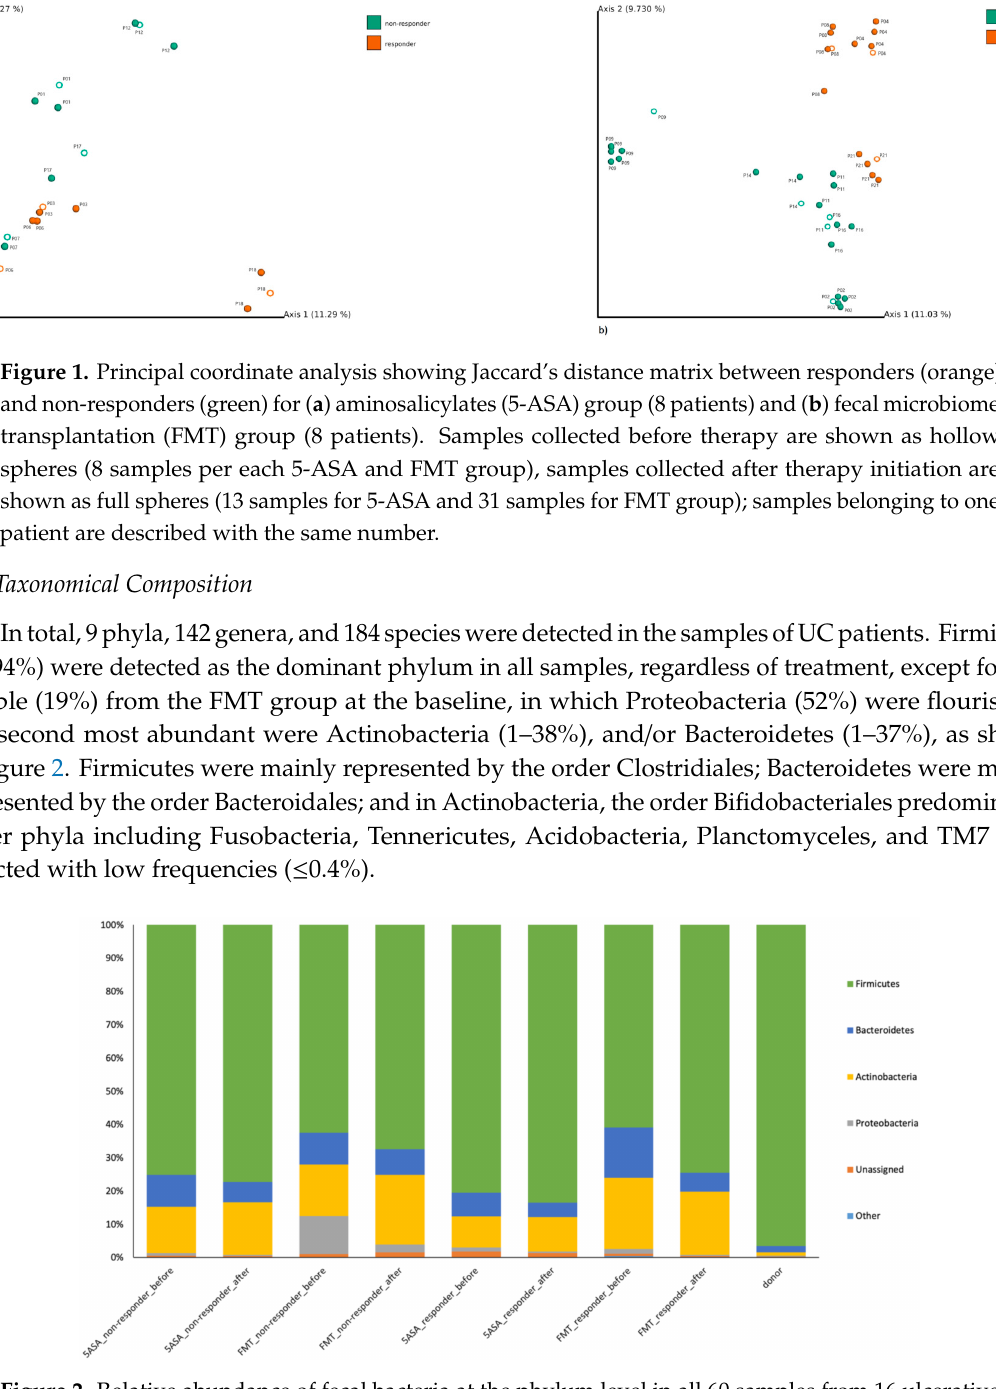
Figure 2. Relative abundance of fecal bacteria at the phylum level in all 60 samples from 16 ulcerative colitis (UC) patients with active left-sided colitis and the donor grouped by therapy type (FMT, 5-